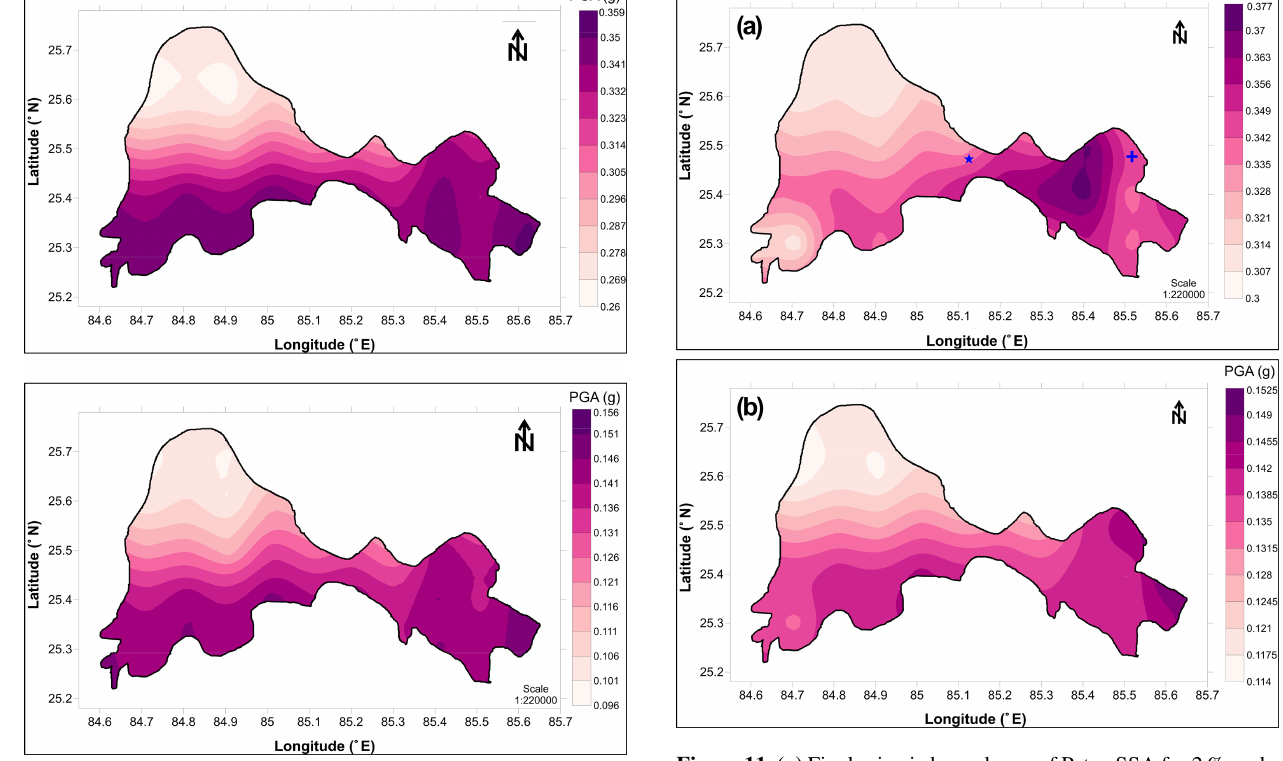
Figure 11. (a) Final seismic hazard map of Patna SSA for 2% prob- ability of exceedance in 50 years using the logic tree approach. (b) Final seismic hazard map of Patna SSA for 10% probability of exceedance in 50 years using the logic tree